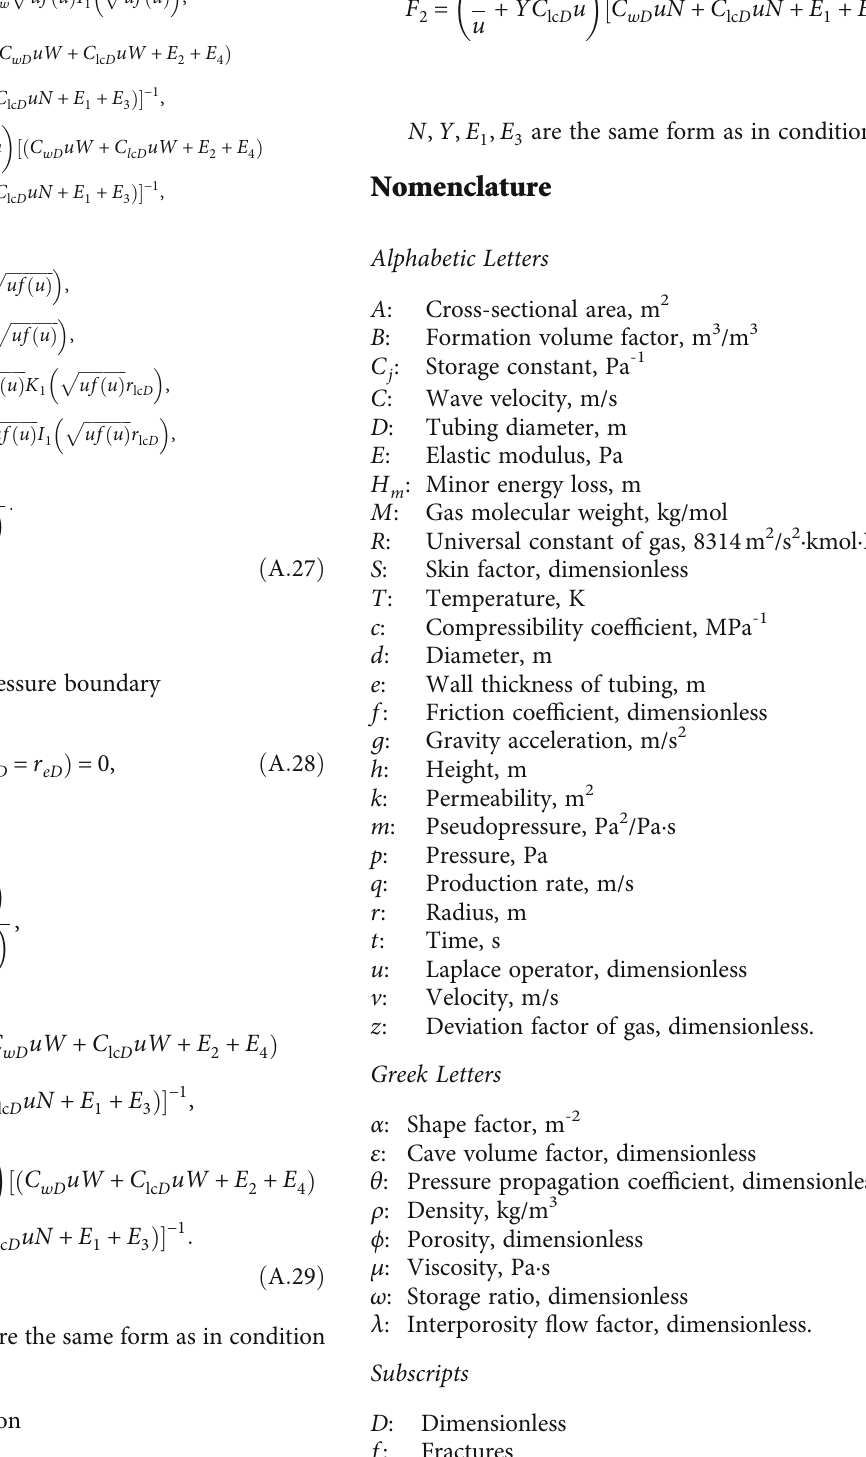
ffiffiffiffiffiffiffiffiffiffiffiffi p ffiffiffiffiffiffiffiffiffiffiffiffi + S uf u ð Þ w p ffiffiffiffiffiffiffiffiffiffiffiffi ffiffiffiffiffiffiffiffiffiffiffiffi − S uf u ð Þ w